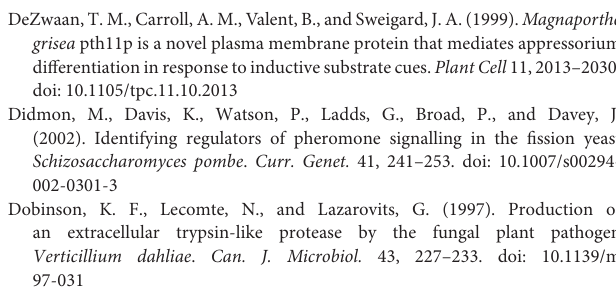
the gene clusters during microsclerotia development ( Xiong et al., 2014). CO and GC represent conidia and conidial germination; MS1-MS4 represents four typical stages during the entire process of microsclerotia formation at 60, 72, 96 h, and 14 days. Table S1 | A list of genes regulated by both VdMcm1 and Vta2 . Table S2 | A list of secreted protein-encoding genes significantly downregulated in 1 VdMcm1 . Table S3 | All the primers used in this